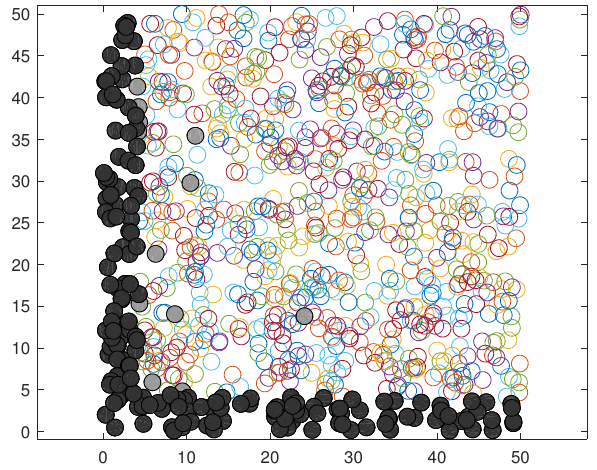
Figure 2. A randomly generated family of sets. The lightly and darkly filled circles belong to the set T generated by Algorithm 2, while the H 2 -approximate minimal elements of the set A are exactly the darkly filled circles (see Example